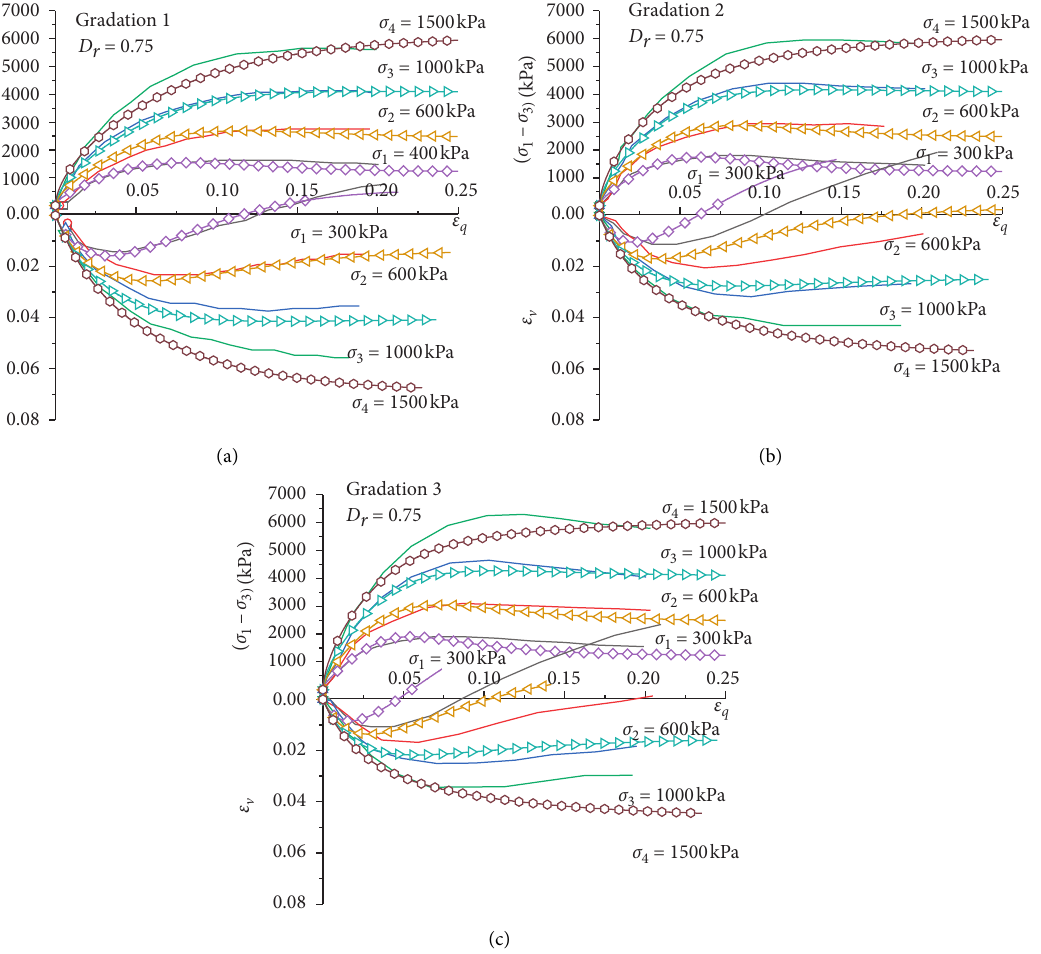
Figure 8: The comparison of test results and the simulation results ( D